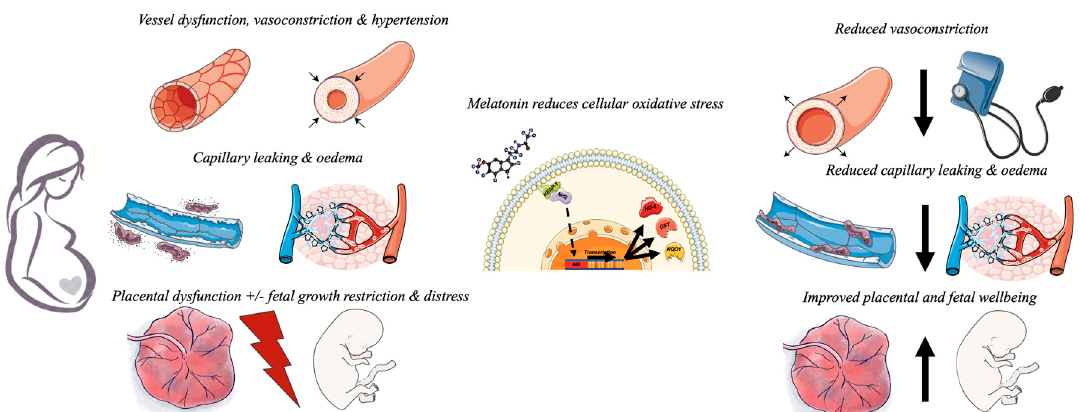
Figure 1. Preeclampsia involves widespread vascular dysfunction resulting in peripheral vasoconstriction which manifests as maternal hypertension. Capillary leakage results in oedema and impaired placental oxygenation results in placental dysfunction and fetal distress with, or without, fetal growth restriction. Melatonin is an antioxidant that reduces oxidative stress within the cells of the placenta and vasculature. Melatonin releases Nrf2 from intracellular binding by KEAP-1 allowing it to translocate to the nucleus of the cell. Here, Nrf2 activates the antioxidant response element of “safeguarding genes” resulting in transcription and translation of a number of antioxidant proteins. These proteins induce redox reactions to neutralise excessive intracellular reactive oxygen species that would otherwise cause damage to DNA and protein production essential for cell function. This allows melatonin to improve vascular function reducing vasoconstriction, reduce capillary leakage and improve placental function. Melatonin may also directly protect the developing fetal